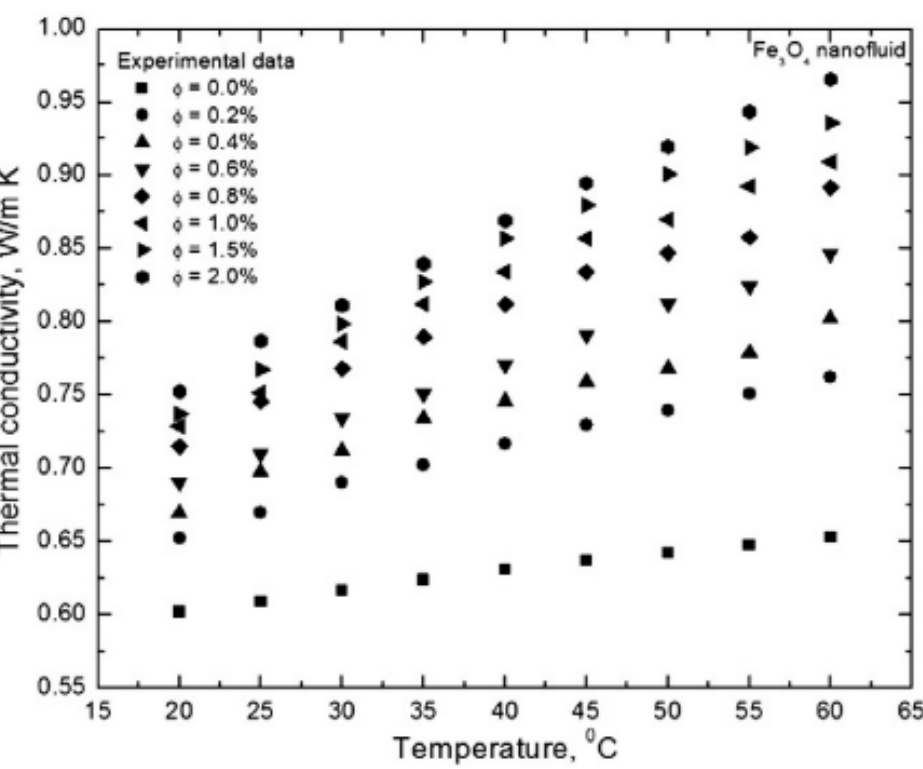
Figure 5. Effect of increasing temperature on thermal conductivity of Fe 3 O 4 /water nanofluids under different volume concentration [64].